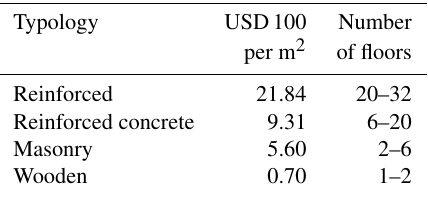
Table 3. The economic value of buildings in the Yuyangguan com- munity (the Department of Natural Resources of Hubei Province,